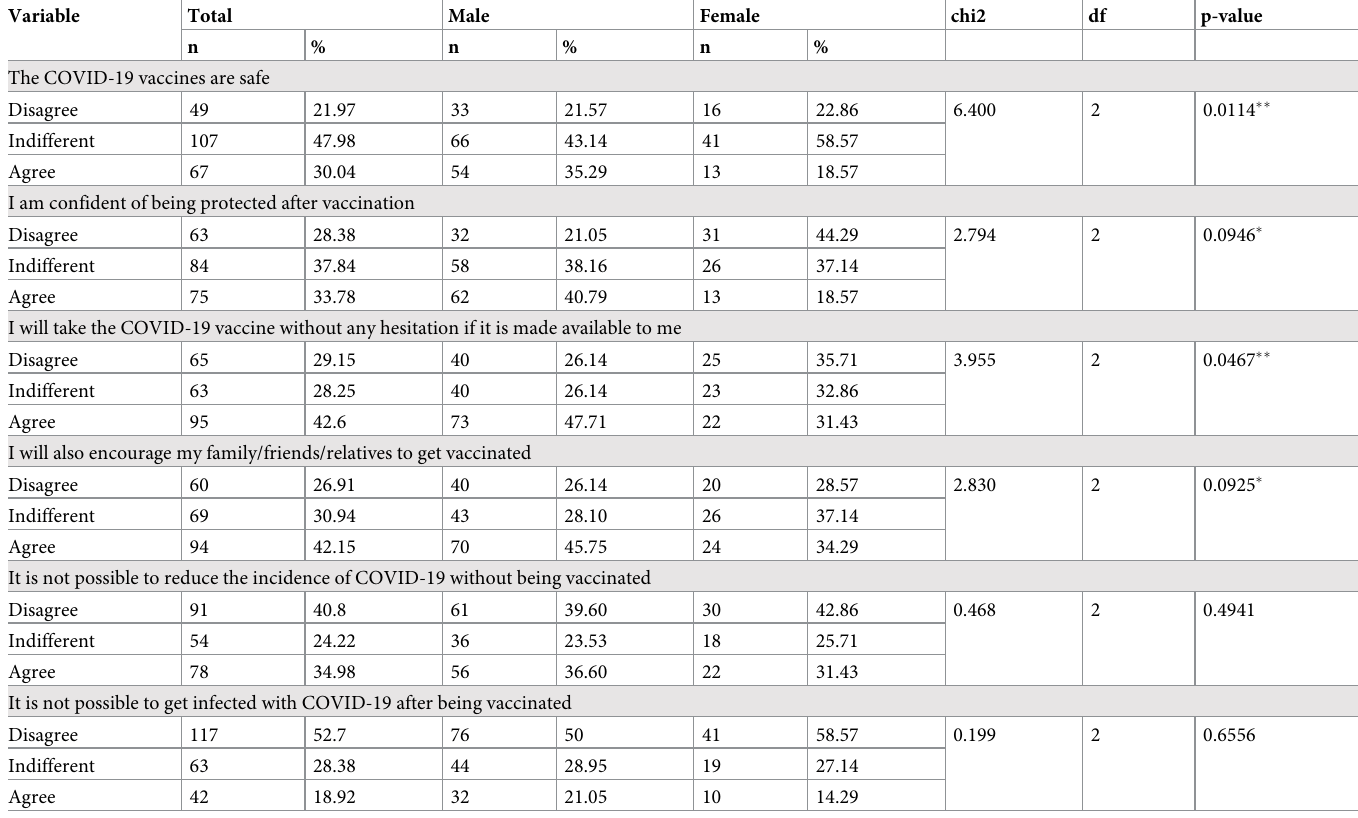
Table 3. Distribution of each attitude item by gender